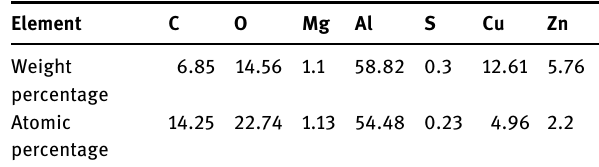
Table 8: Element analyses of corrosion products of aluminium